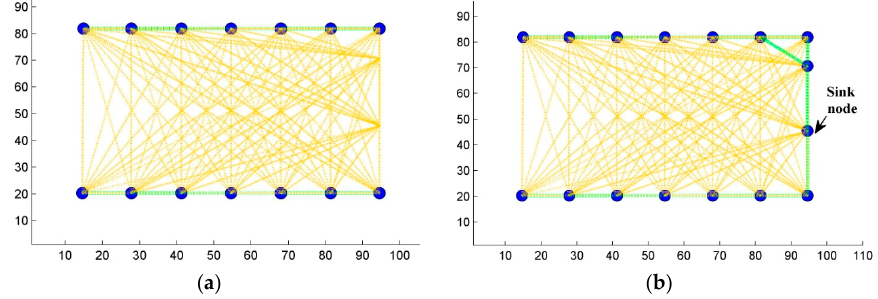
Figure 18. Illustration of WSN connection graph: ( a ) Before solving connectivity ( b ) after solving connectivity.